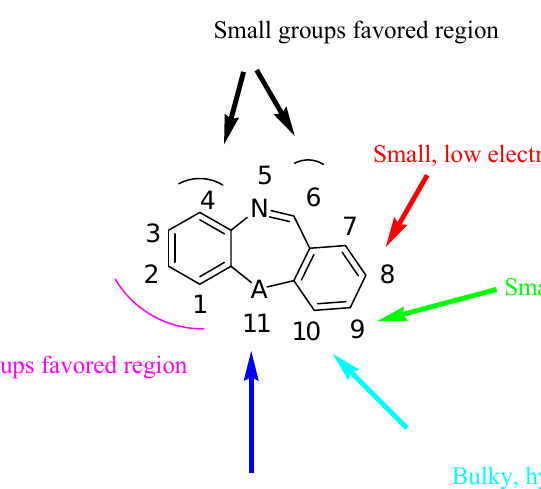
Figure 10 . Structure-activity relationship revealed by 3D-QSAR studies.